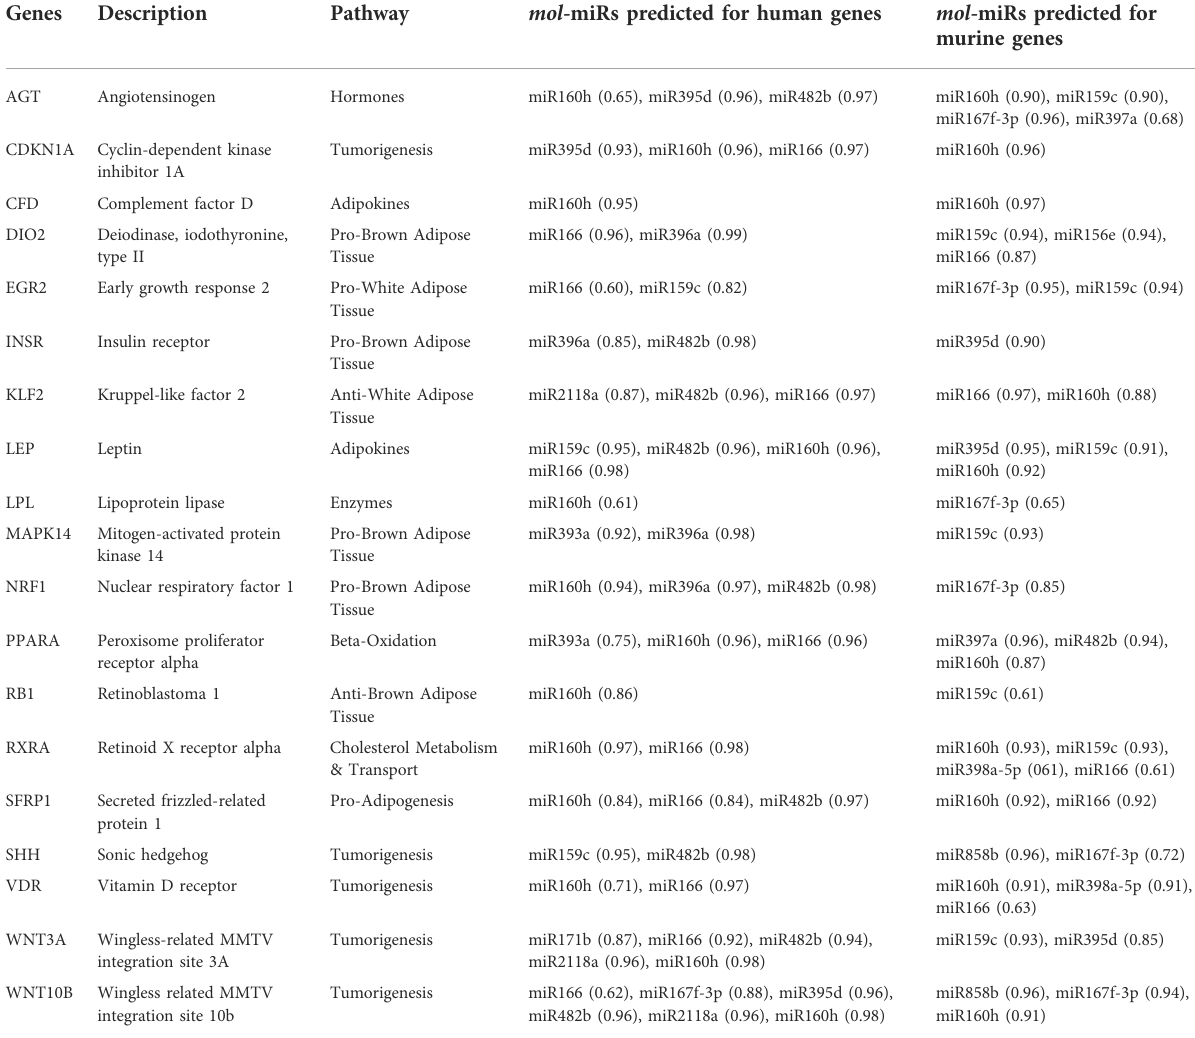
TABLE 3 List of the nineteen mol- miRs target genes in common between Homo sapiens and Mus musculus, with relative mol- miRs and binding energy shown as score.